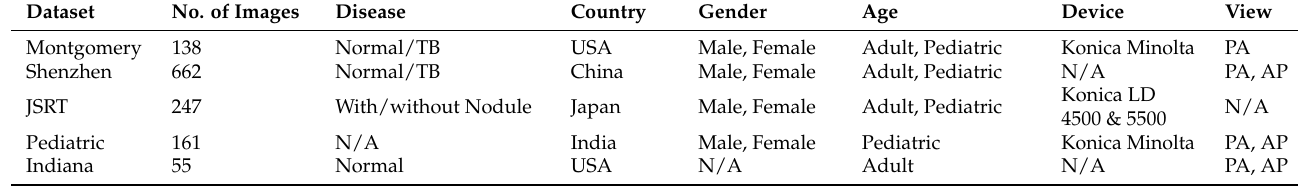
Table 1. Comparison of datasets